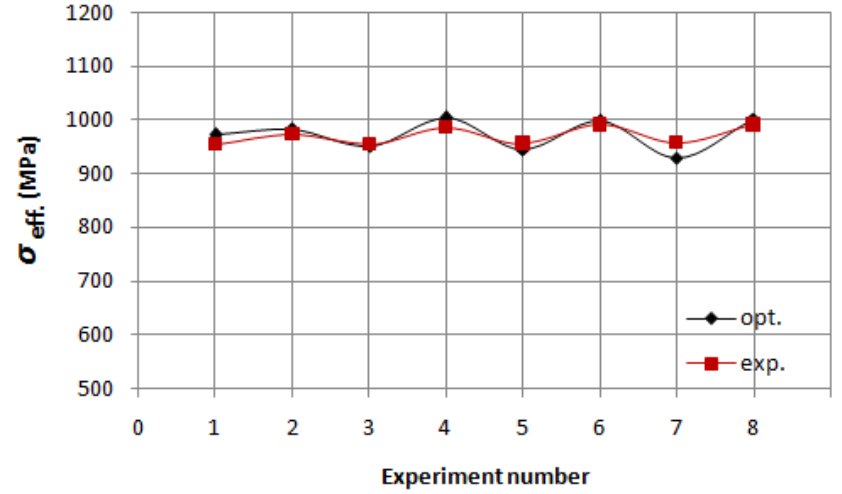
Figure 22. Comparison of DE optimal and experimental values for effective